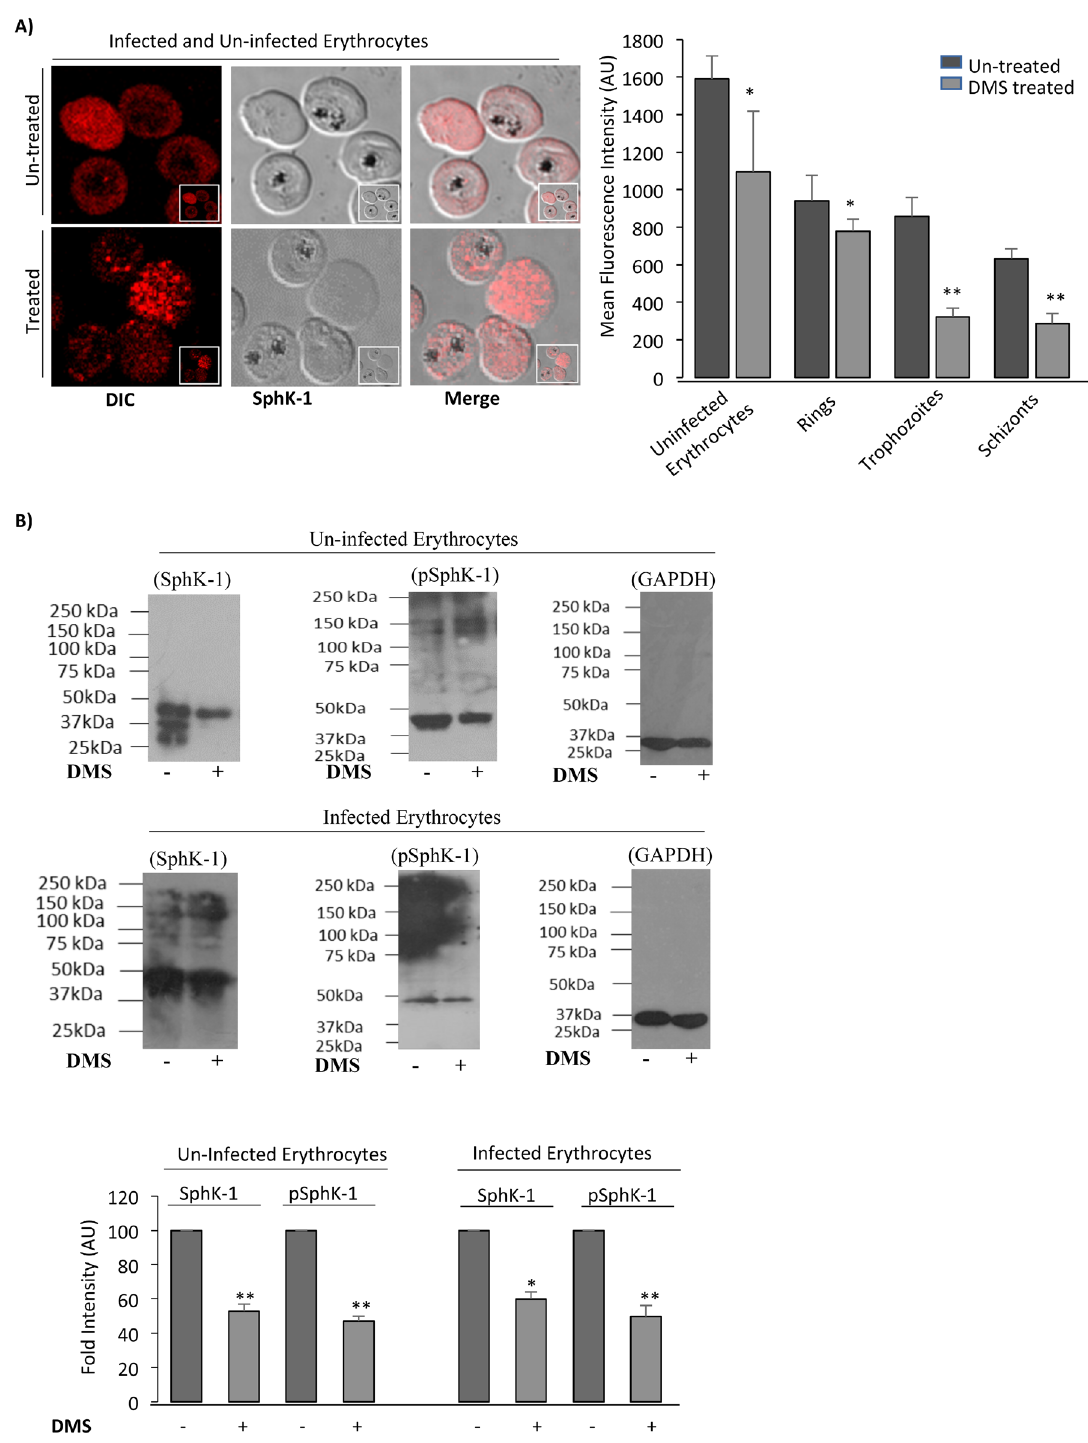
Figure 2. Inhibition of host SphK-1 by specific inhibitor DMS causes decrease in SphK-1 protein level and phosphorylation. ( A ) Confocal micrographs demonstrate altered host SphK-1 level in mixed-stage parasite culture following treatment with DMS (14 µM). Bar graph denotes the differential mean fluorescence intensity (MFI) denoting host SphK-1 level in infected and uninfected erythrocytes following DMS treatment. The supportive immunofluorescence micrograph was incorporated in Supplementary Fig. 4. ( B ) The representative uncropped immunoblots show phosphorylation status of SphK-1 and its level in treated and untreated cells. Total cell lysates probed with GAPDH was used as a loading control. The graph represents fold change in the band intensity in individual lanes for two individual experiments. Three independent experiment have been performed, n = 3, * p ≤